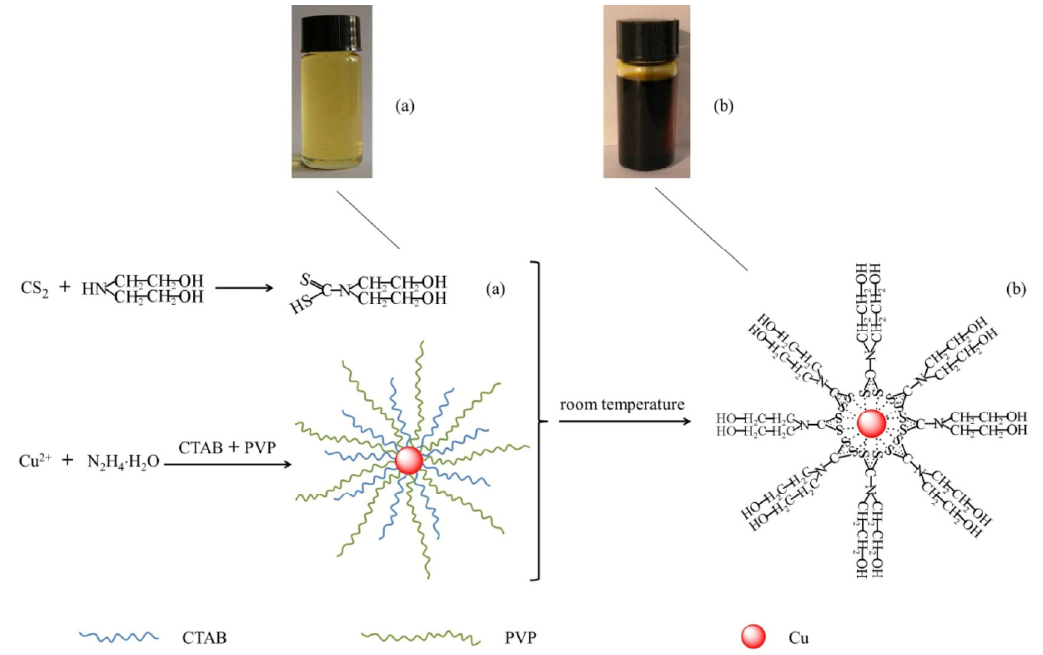
Fig. 1 Schematic illustration for the reaction pathway and corresponding optical pictures of products (a) HDA modifier and (b) water- soluble Cu